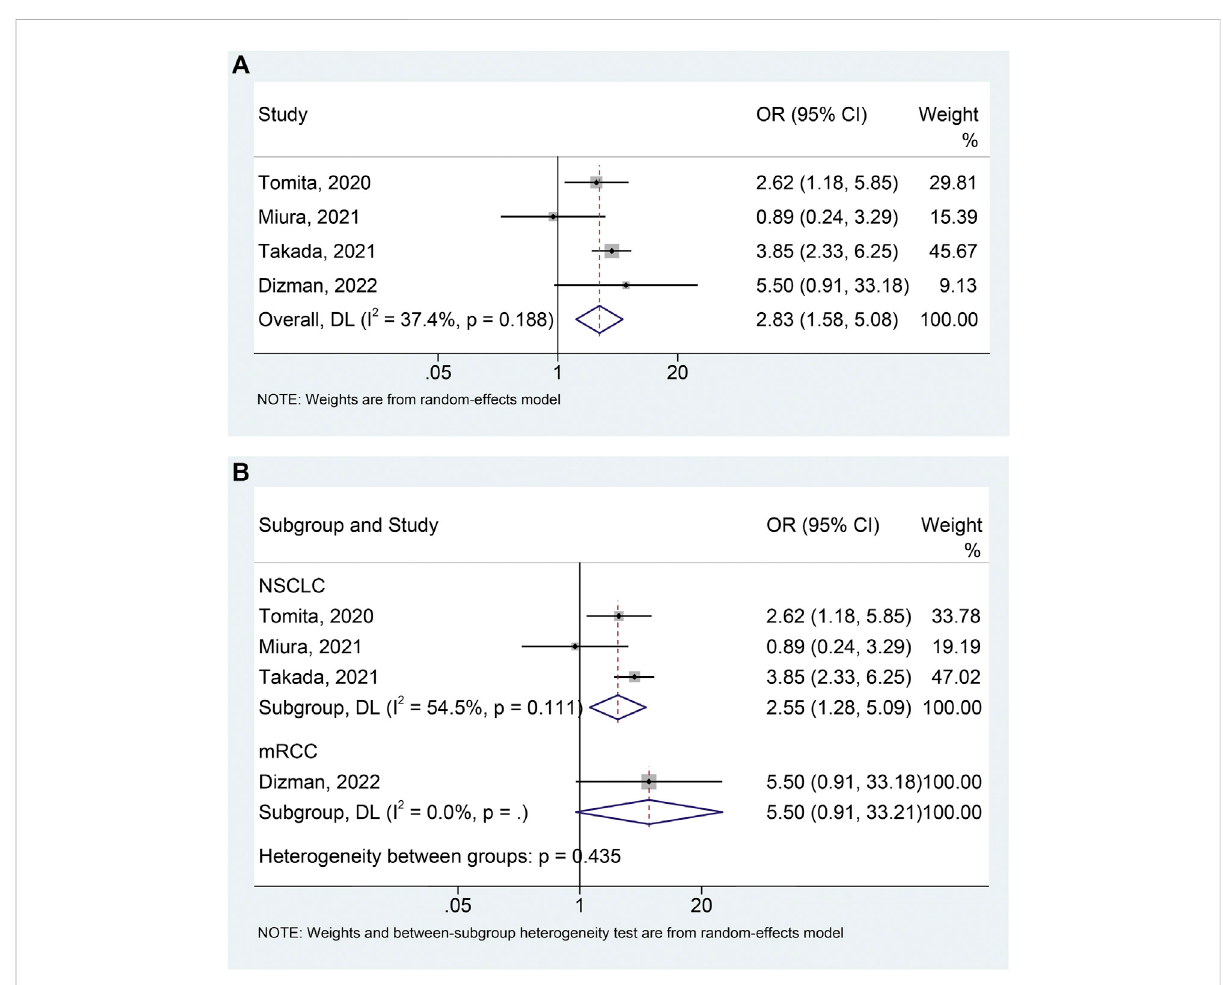
FIGURE 4 ForestplotsofORfortheassociationofprobioticusagewithobjectiveresponserate (A) .Subgroupanalysisoftheobjectiveresponseratebased on cancer types (B) . NSCLC, non-small cell lung cancer; mRCC, metastatic renal cell carcinoma; OR, odds ratio; CL, con fi dence interval; Univariate analysis (Tomita et al., 2020; Dizman et al., 2022); Multivariable analysis (Miura et al., 2021; Takada et al.,